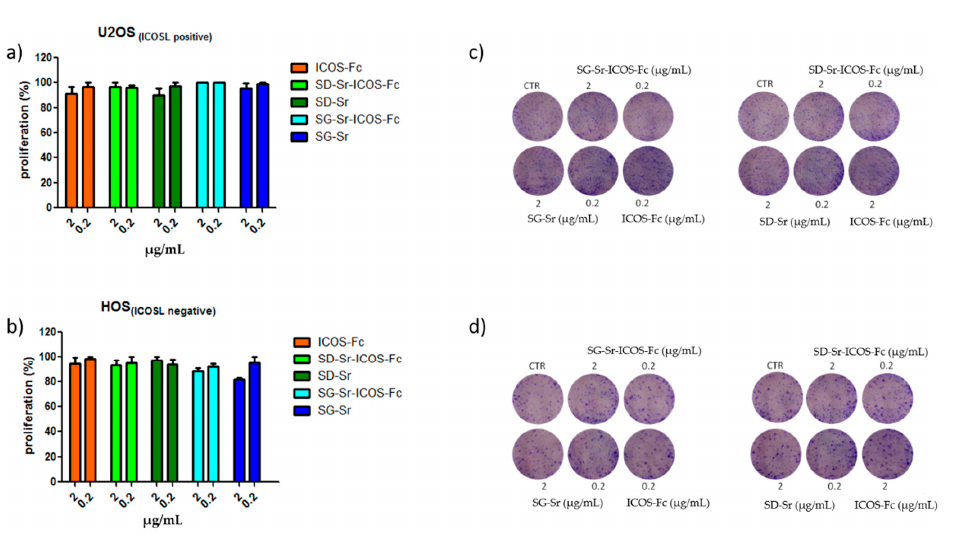
Figure 14. Clonogenic assay: ( a ) U2OS; ( b ) HOS. Cells were treated with ICOS-Fc, SD-Sr-ICOS-Fc, SD-Sr, SG-Sr-ICOS-Fc, and SG-Sr at 2 and 0.2 µg/mL concentration for 72 h. Then, the cell medium was changed, and the cells were cultured for additional 7 days in a free medium ( c ), ( d ) Colonies were then photographed. Then, the cells were treated with acetic acid to induce a completely dissolution of the crystal violet and absorbance was evaluated. Three different experiments were performed. Data are shown as mean ± SEM.